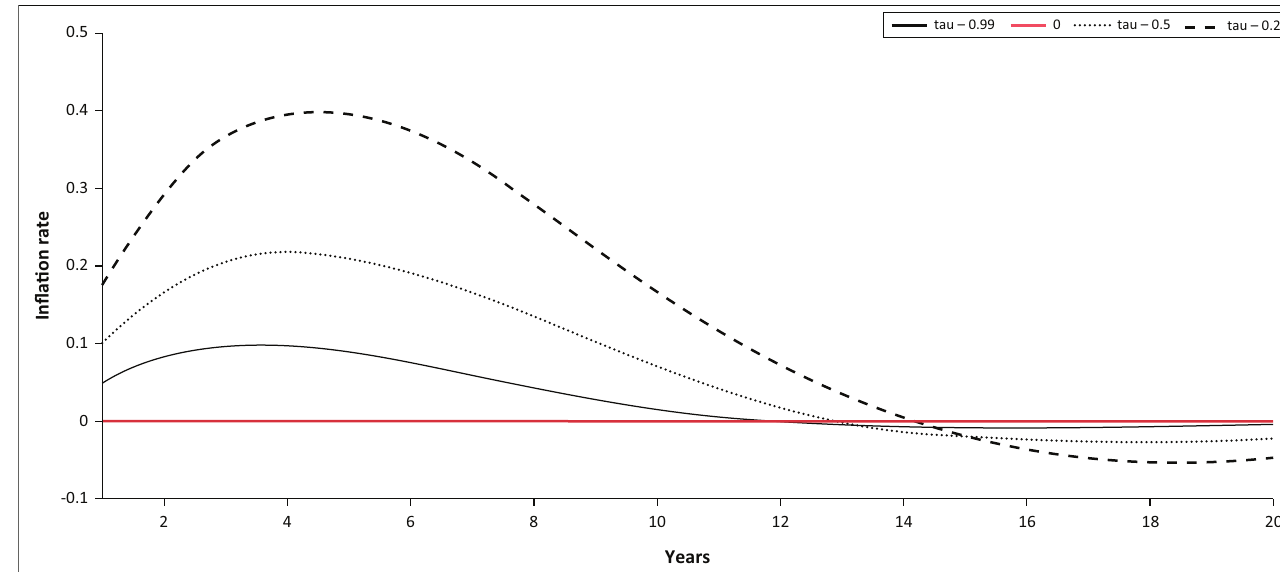
FIG URE 2: Impulse responses of inflation to a monetary tightening policy shock.